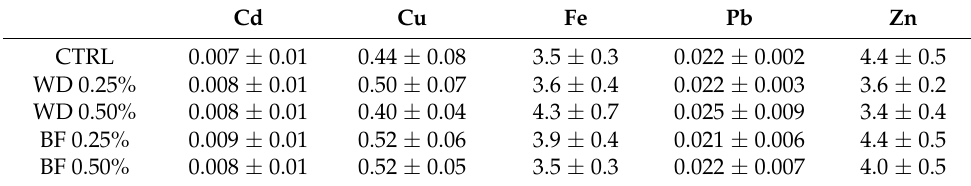
Table 3. The content of potentially toxic elements in lettuce leaves (mg/kg fw, median ± error) after four weekly foliar treatments with water (CTRL), 0.25% and 0.5% wood distillate (WD), and WD added with 3% soy lecithin and 5% flavonoid-rich wood glycolic extract (BF). For all elements, no statistically significant differences between treatments were found.